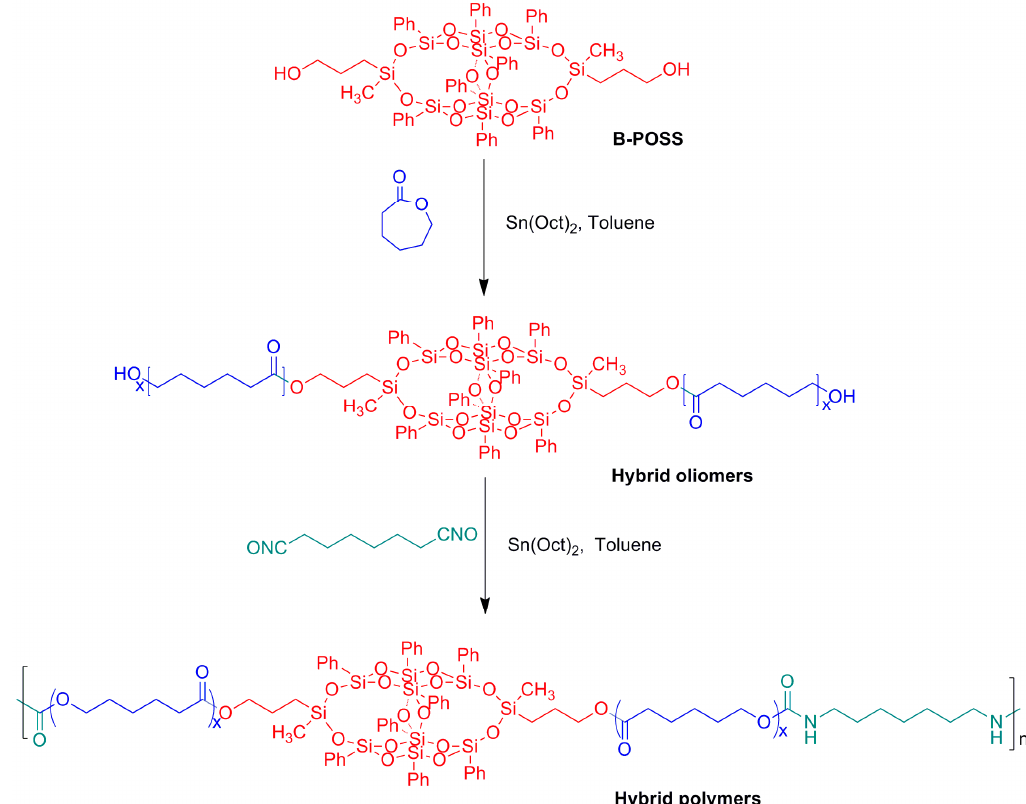
Figure 1. Synthesis of organic–inorganic hybrid PUs with B-POSS in the main chains.